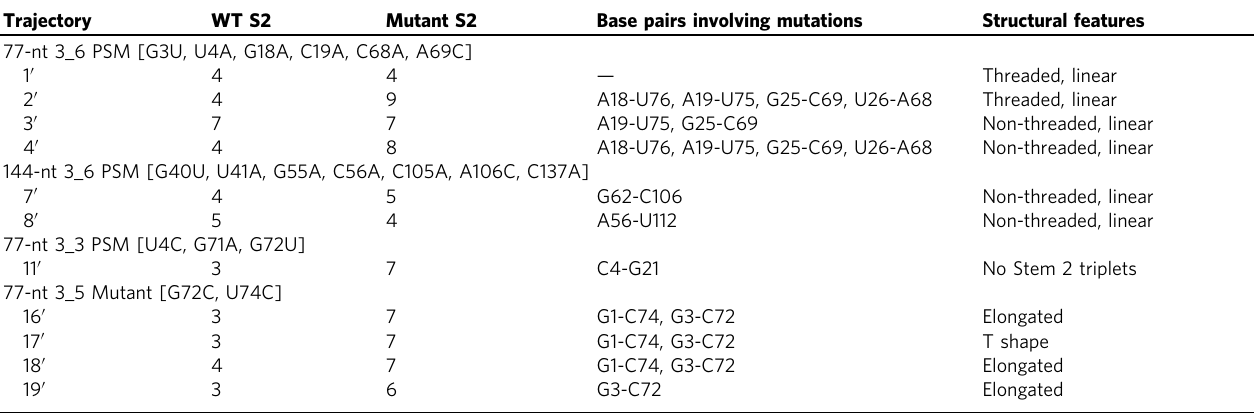
For each mutant, the mutations, the trajectories as numbered in Table 1, the wildtype and mutant Stem 2 lengths, the newly formed Stem 2 base pairs involving the mutated residues, and the structural features are